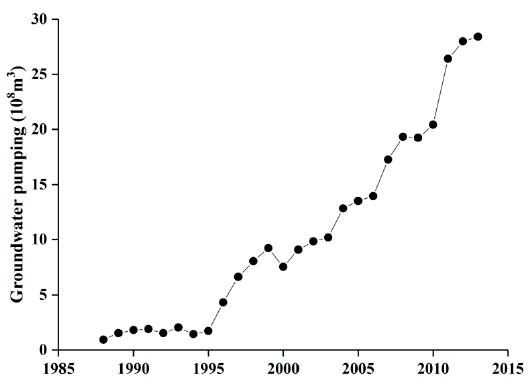
Figure 7. Groundwater pumping during 1988–2013 in the Naoli River Basin, Northeast